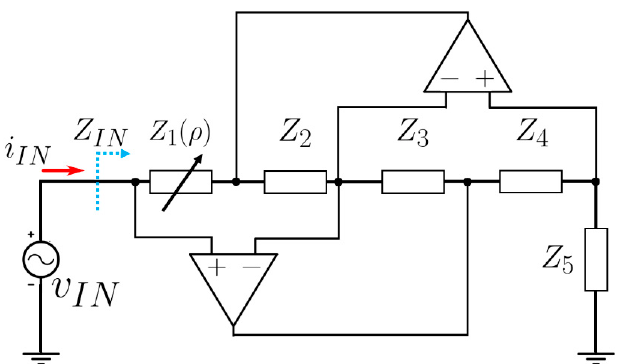
Figure 2. Schematic of the meminductor emulator based on Antoniou’s circuit. The different passive elements are represented by their impedance ( Z i ; i = 1, ..., 4). Z ( ρ ) represents a time integral of the flux (TIF)-dependent impedance, while υ IN , i IN and Z IN represent the input voltage, current and impedance, respectively.